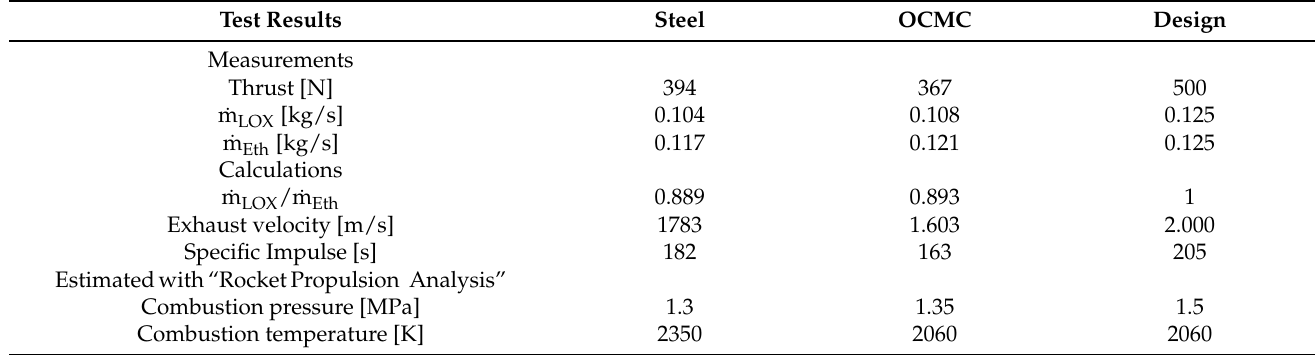
Figure 29. Results of the hot tests of the steel combustion chamber ( left ) and the OCMC combustion chamber ( right ) in comparison. Table 4. Results of the hot tests compared with the design